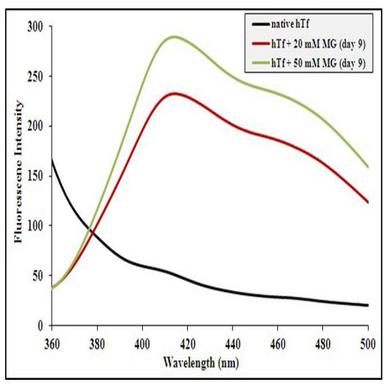
AGEs specific fluorescence. Fluorescence intensity of pentosidine-like AGEs formed upon incubating human transferrin with 20 mM and 50 mM MG for 9 days.